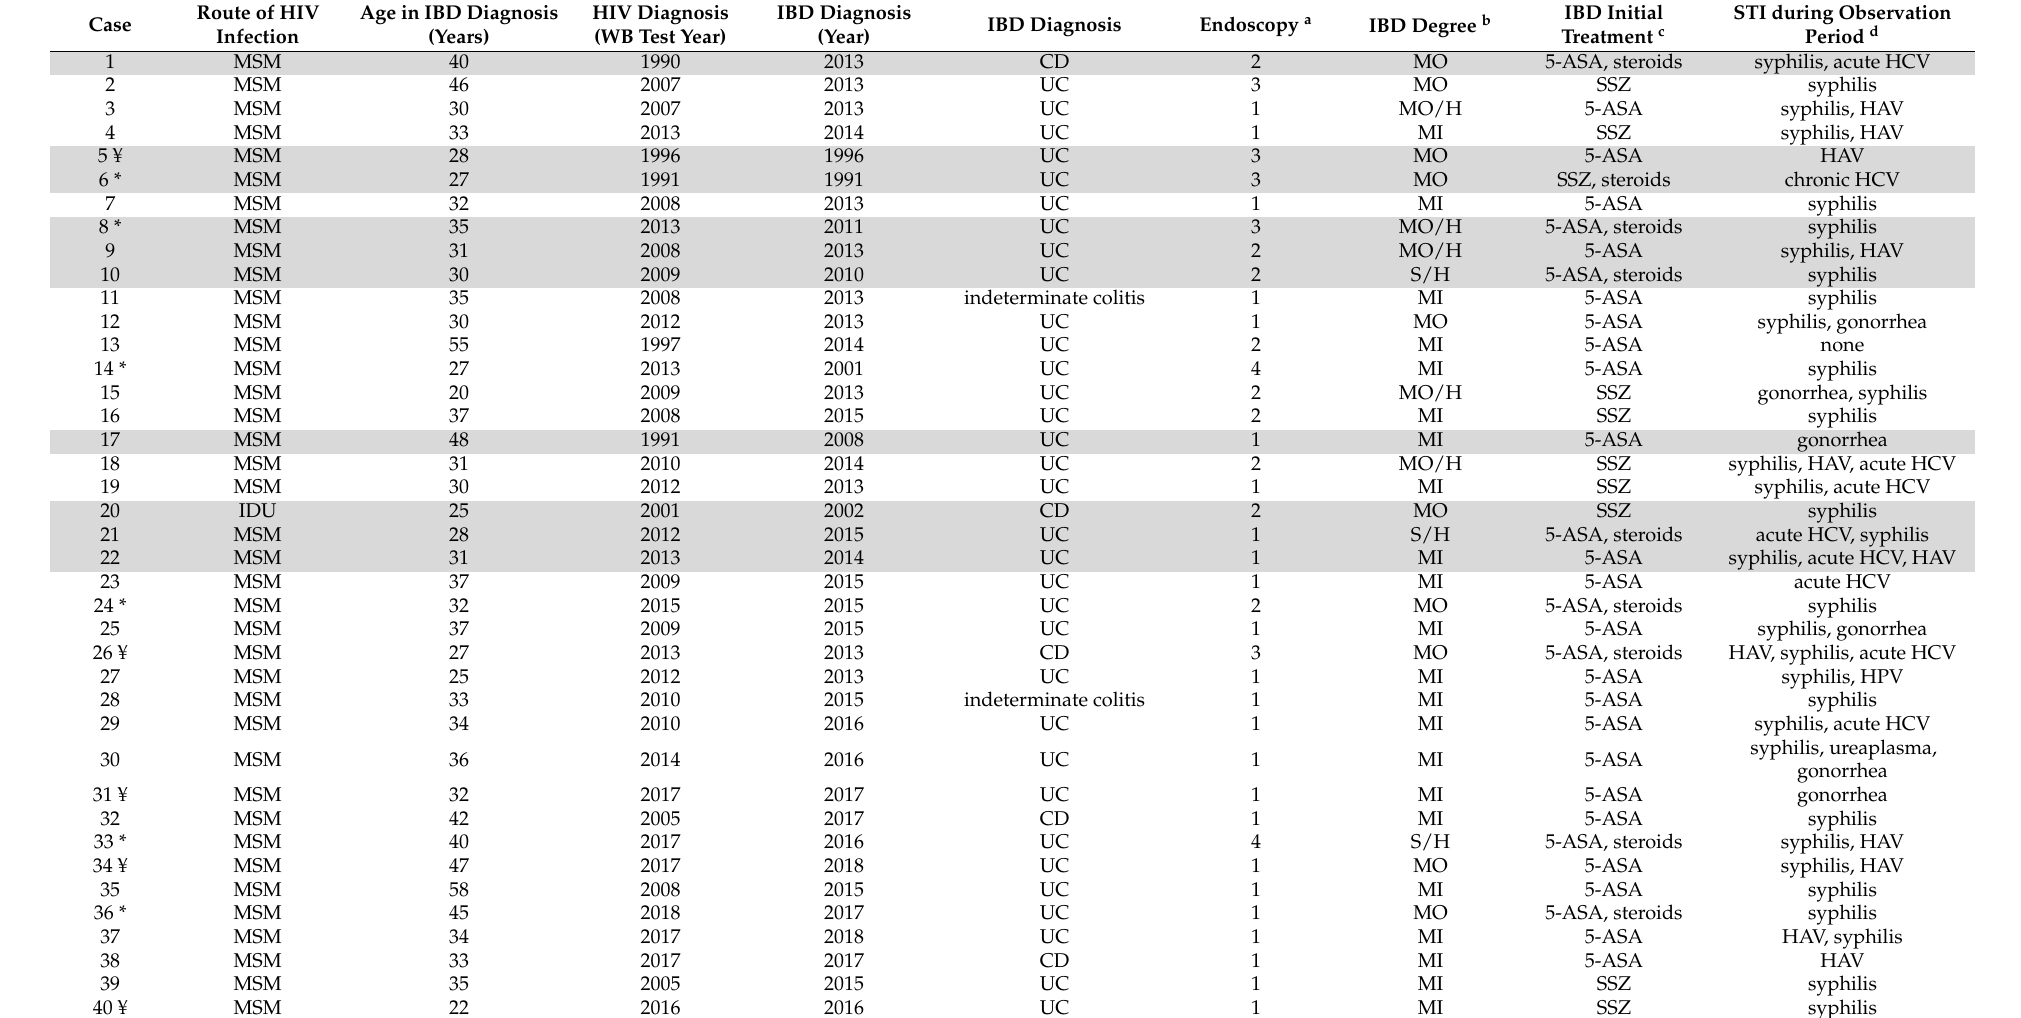
Table 2. The clinical and endoscopic characteristics of the studied group concerning IBD diagnosis and concomitant